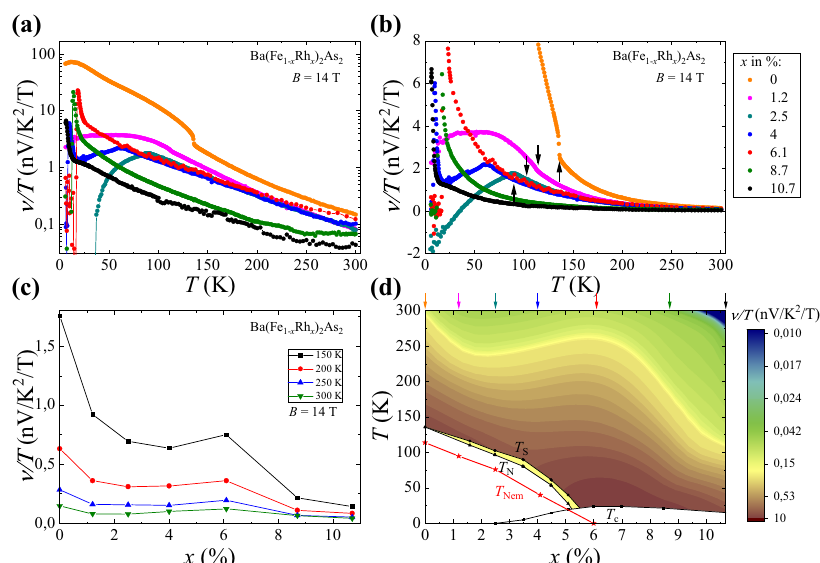
Fig. 2 Nernst effect measurements in Ba(Fe 1 − x Rh x ) 2 As 2 . Nernst coef fi cient divided by temperature ν / T of Ba(Fe 1 − x Rh x ) 2 As 2 as a function of T and x . All data measured along the ab -plane with a magnetic fi eld of B = 14T applied parallel to the c -axis. a ν / T as a function of temperature (note the semi-logarithmic scale). b Zoom-in on the data shown in panel ( a ). Black arrows indicate structural phase transitions. c ν / T vs. Rh doping level x at selected temperatures. d Colour coded phase diagram of the Nernst coef fi cient divided by temperature ν / T as a function of Rh doping level x and temperature T . Coloured arrows on the top mark show the nominal doping of the measured samples. T S , T N , and T c data taken from ref. 20 . T nem data is obtained from elastoresistivity measurements on the same samples (compare “ Methods ”